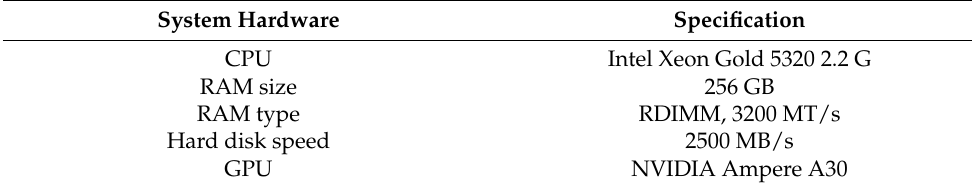
Table 2. Computing server hardware configuration.